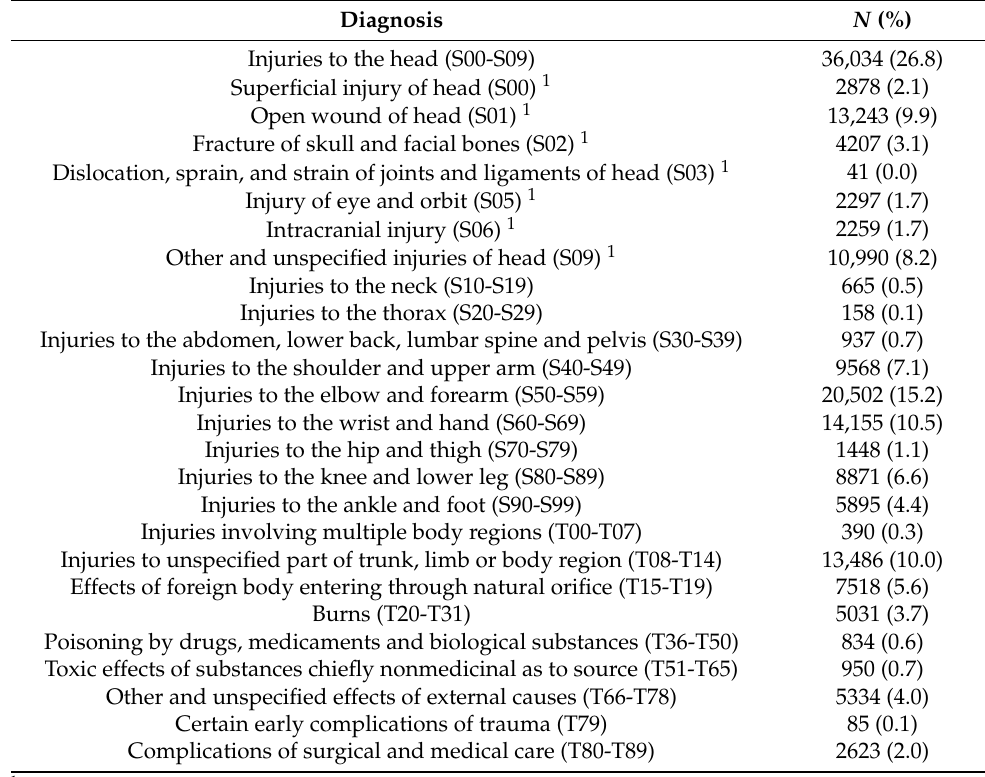
Figure 1. Distribution of paediatric injury-related ED presentations by sex and age, 1 January 2010 to 31 December 2019 ( N = 134,484). Table 2. Frequencies and proportions of paediatric injury-related ED presentations, 1 January 2010 to 31 December 2019 ( N = 134,484).